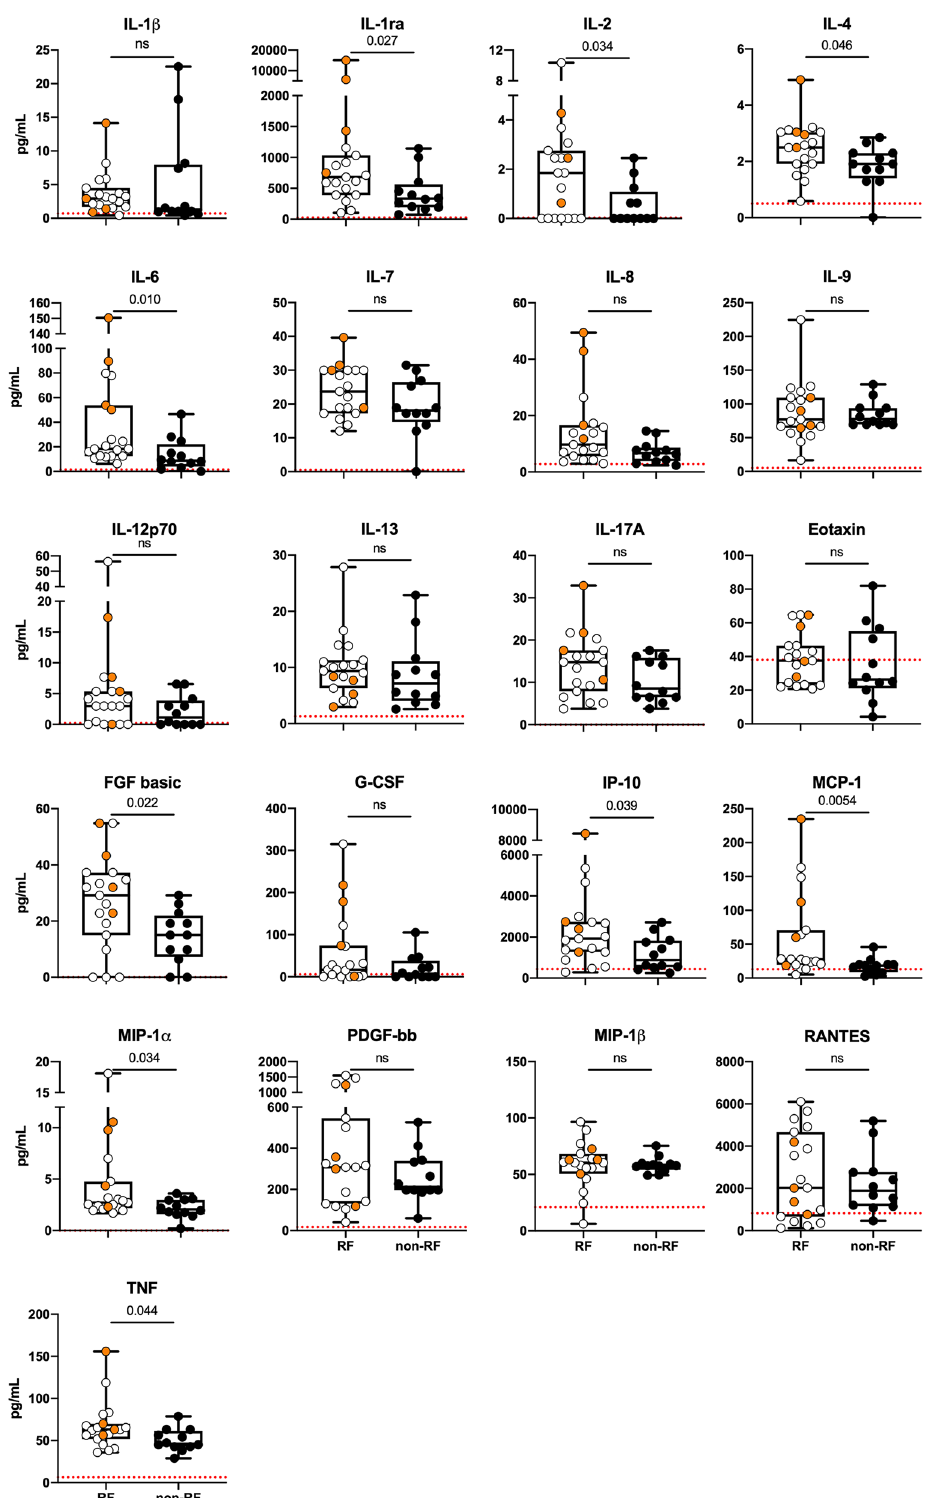
Figure 1. Cytokines at admission in COVID-19 patients with respiratory failure. Twenty-one cytokines had detectable levels in plasma from COVID-19 patients at admission to hospital. The levels of IL-1ra, IL-2, IL-4, IL-6, FGF basic, MCP-1, MIP-1α and TNF were significantly higher in patients with RF (n = 19) compared to non-RF patients (n = 12). For three patients baseline samples were not available and these were excluded from the analysis set. Patients that died during hospitalization (n = 4) are shown in orange circles. Red lines indicate reference values by Hennø et al. 31 . Groups were compared using Mann U Whitney test, significance * <